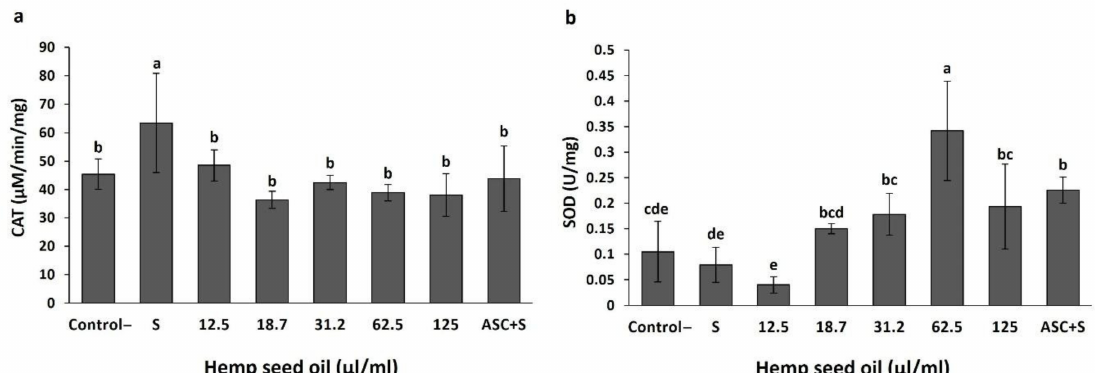
Figure 4. Effects of hemp seed oil on the activity of the antioxidative enzymes catalase (CAT) ( a ) and superoxide dismutase (SOD) ( b ) in D. melanogaster larvae under chronic H 2 O 2 -induced oxidative stress. The hemp seed oil was applied to the H 2 O 2 -contained feeding medium at six concentrations (0 (S), 12.5, 18.7, 31.2, 62.5, 125 µ L/mL), then compared to an unstressed negative control (control-) and a positive control of ascorbic acid (ASC + S). All values are expressed as means ± SD. Different letters above the means represent significant differences between treatments ( p < 0.05, LSD